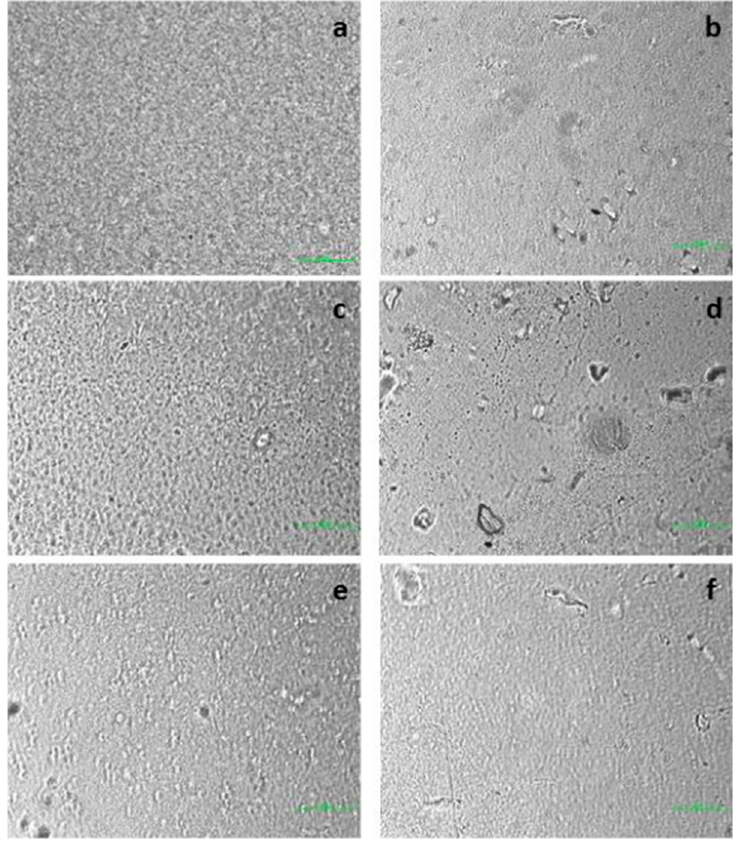
Figure 4. Surface micrographs of: ( a ) SA; ( b ) SA 0.30 ; ( c ) Pe; ( d ) Pe 0.30 ; ( e ) SA + Pe and ( f ) SA + Pe 0.30 films.